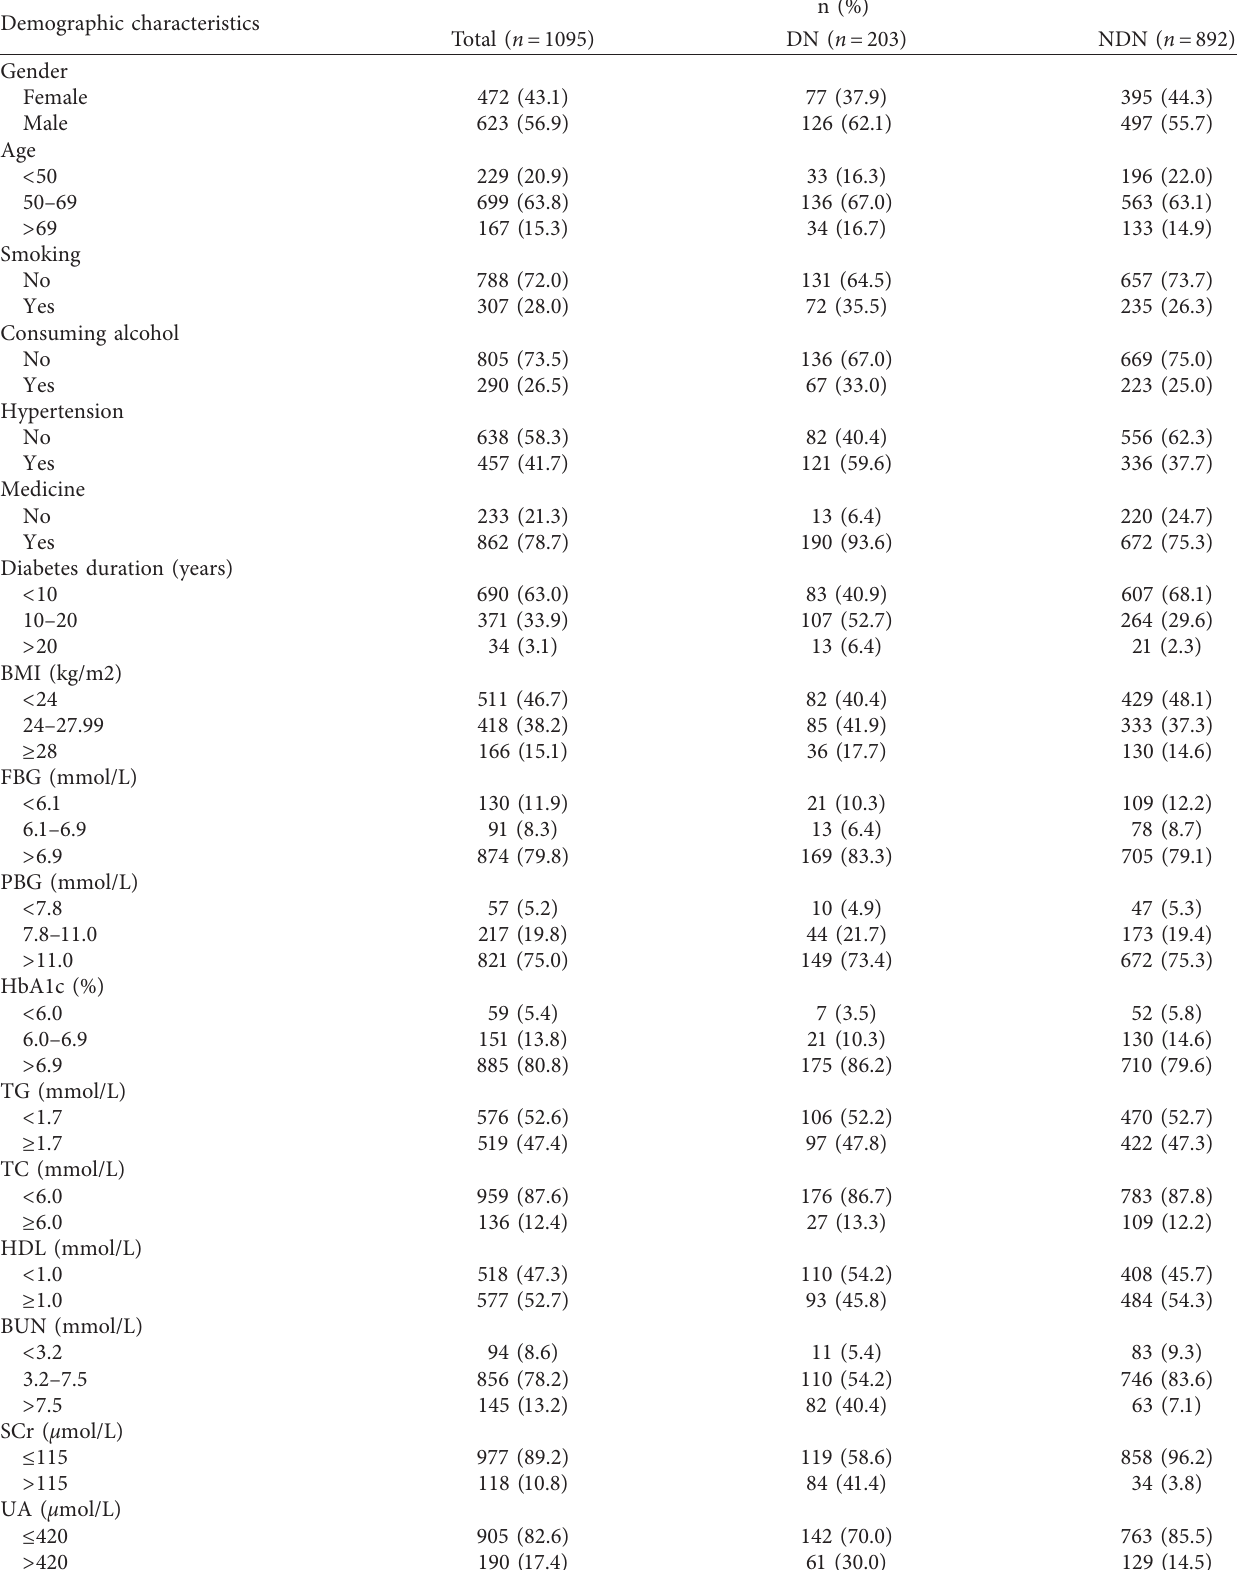
Table 1: Demographic and clinical characteristics between the DN and NDN groups. Demographic